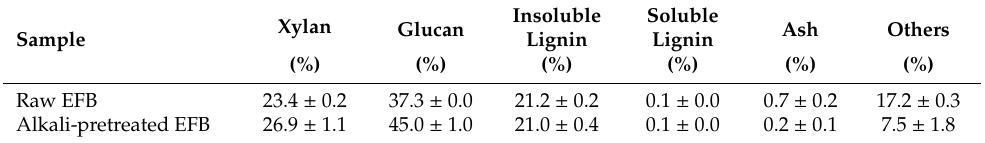
Table 1. Chemical composition (%, w / w ) of empty fruit bunch (EFB) before and after alkali pretreatment.